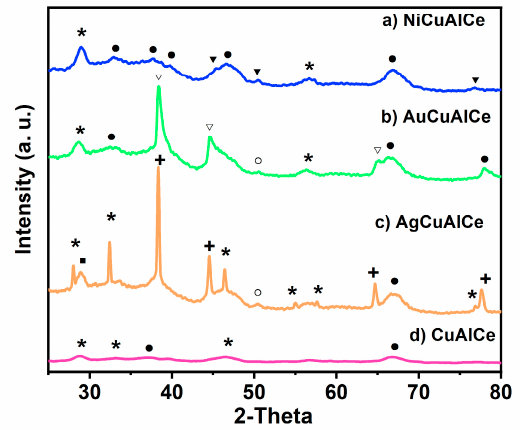
Figure 2. XRD patterns of ( a ) NiCuAlCe, ( b ) AuCuAlCe, ( c ) AgCuAlCe bimetallic-supported catalysts and ( d ) CuAlCe monometallic-supported catalyst, (+) Ag, ( ) Cu, ( ) Cu 2 O, ( ) Au, ( ) Ni, ( ) Ce, ( ) Al.